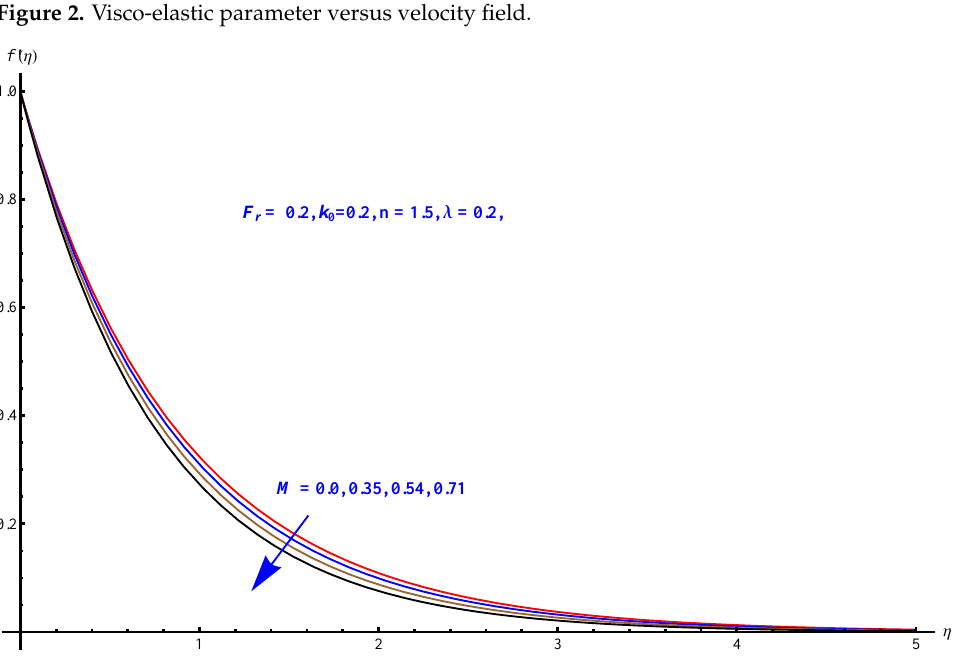
Figure 2. Visco-elastic parameter versus velocity field.